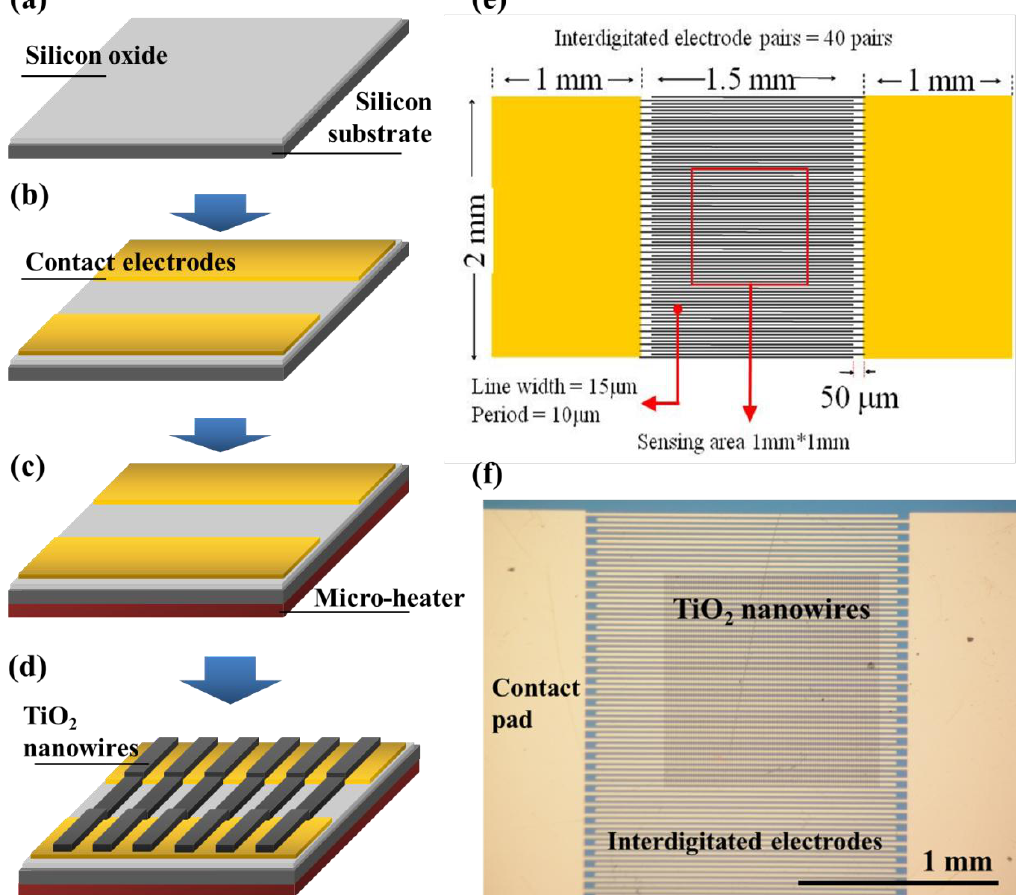
Figure 1. Device fabrication process: ( a ) Thermal oxidation of bulk Si wafer; ( b ) Deposition of Cr/Au for contact electrodes; ( c ) Deposition of Cr/Au on the backside of the Si subtract for the microheater; ( d ) E-beam lithography and TiO deposition followed 2 by the lift-off process and ( e ) illustration of electrode and sensing film design on Si chips and ( f ) photo images of the TiO nanowire array bridging at the integrated 2